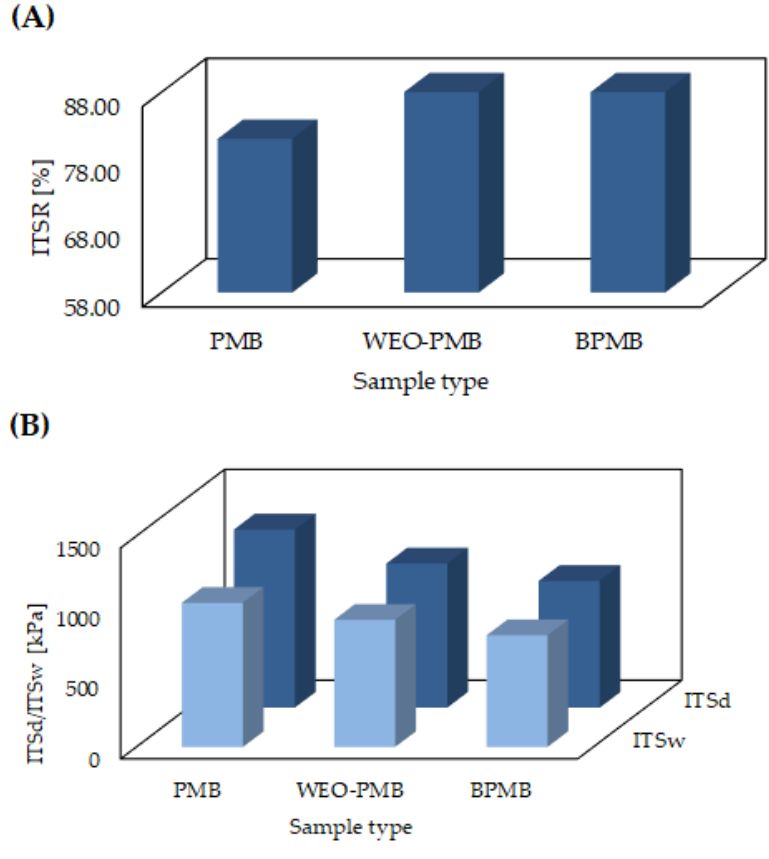
Figure 8. ITSR ( A ), ITSw and ITSd ( B ) of the PMB, WEO-PMB and BPMB mixtures.